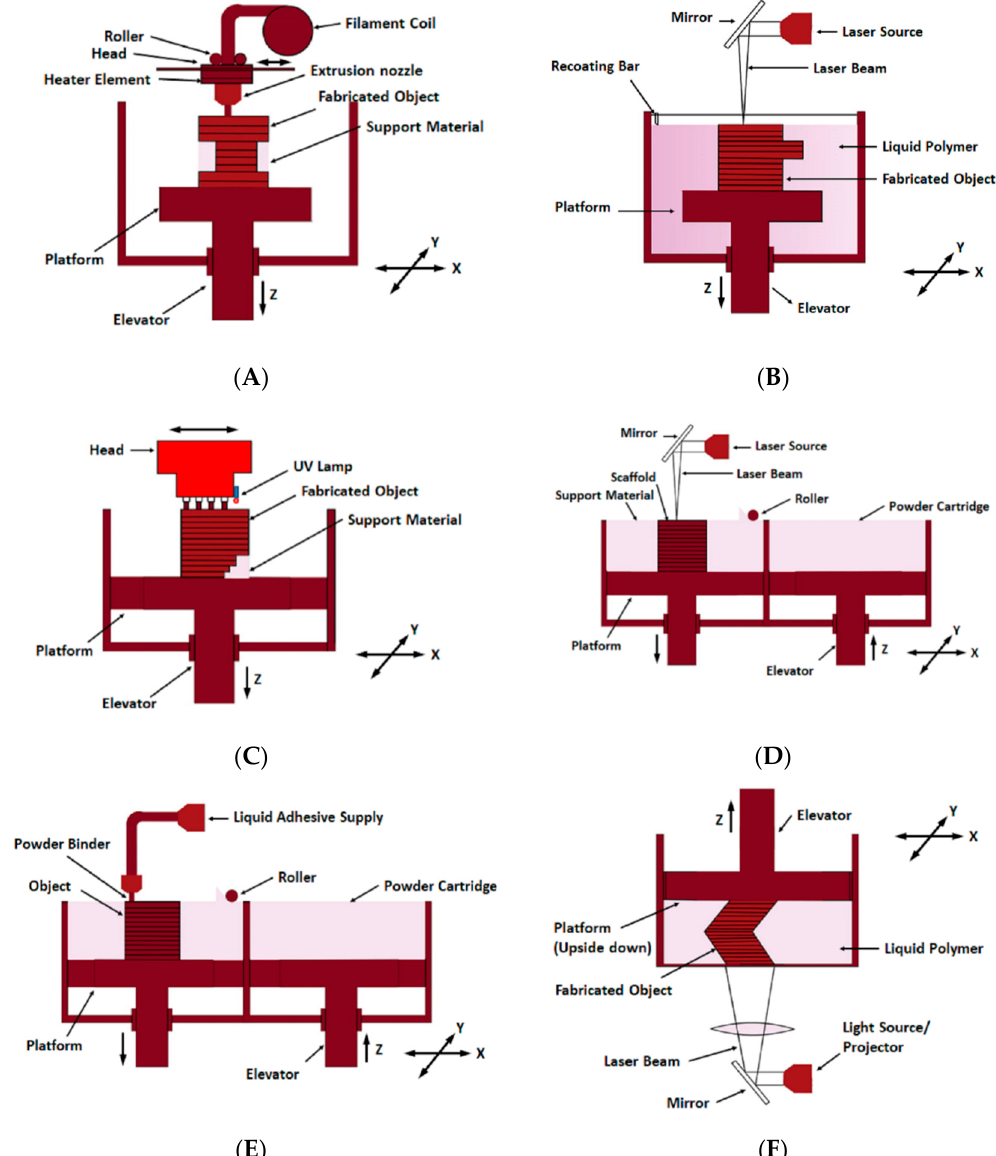
Figure 1. ( A ) Fused deposition modelling ( B ) Stereo-lithography ( C ) Polyjet Process ( D ) Selective laser sintering ( E ) 3D Inkjet printing ( F ) Digital light processing. sintering ( E ) 3D Inkjet printing ( F ) Digital light